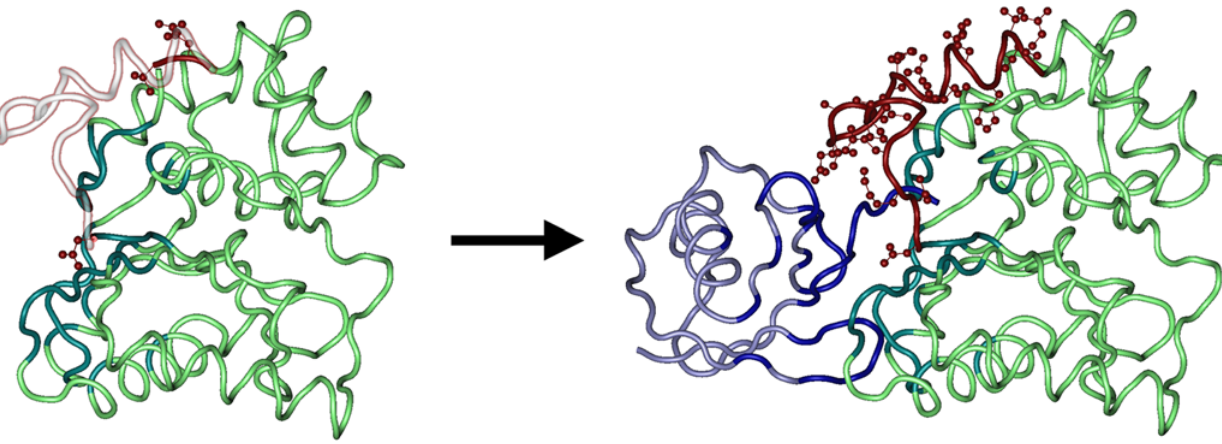
Figure 7. Disorder-to-order transition upon complex formation in ubiquitin C -terminal hydrolase. Structures of two forms of the hydrolase are shown to demonstrate the disordered region which becomes ordered upon complex formation. On the left side is the monomeric ubiquitin hydrolase (1UCH) with the residue at either end of the disordered region highlighted in red and shown with sidechains. On the right side is the complex between ubiquitin hydrolase and ubiquitin with the same residues highlighted in red and sidechains drawn. To trace the disordered region, the ordered region on the right has been mapped to the monomeric structure on the left using a superposition between the two structures and is shown as a silhouette.